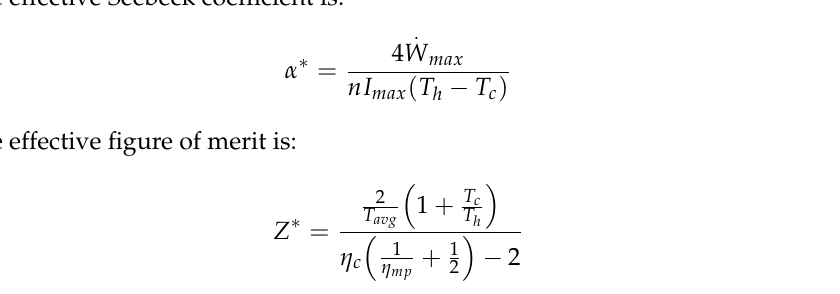
( b ) Figure 5. Experimental setup: ( a ) overview; ( b ) top view of the test section.